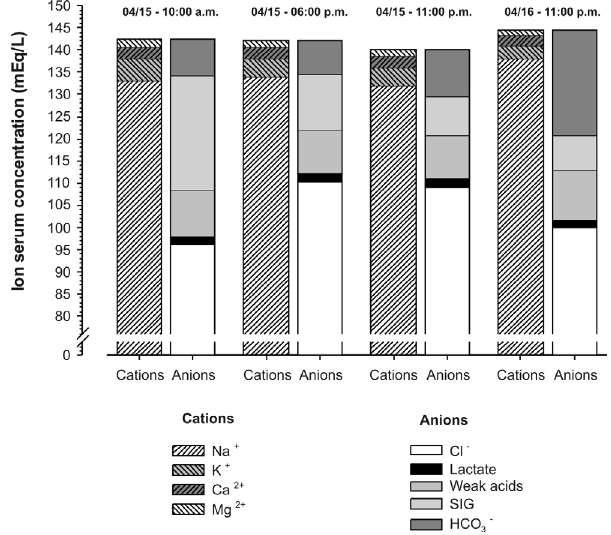
Figure 1 - Evolutive gamblegrams during the course of diabetic ketoacidosis